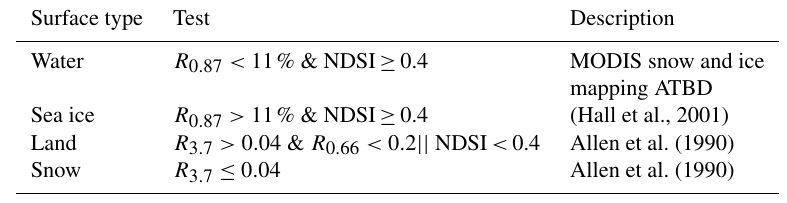
Table 3. Land classification criteria in the cloud-free scene.